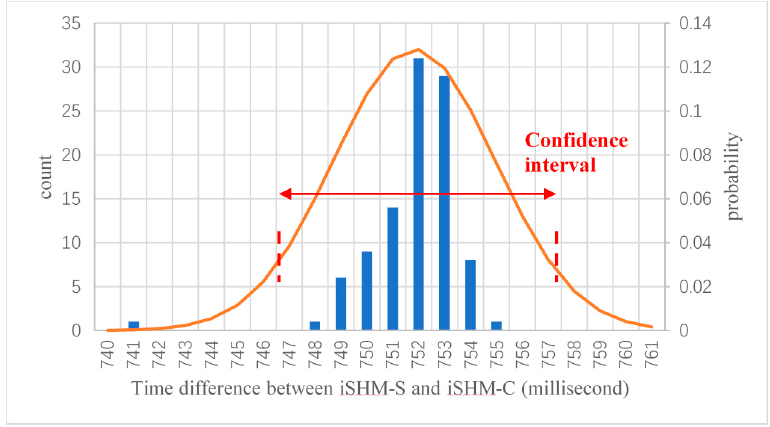
Figure 8. Distribution of estimated time differences Δ𝑡 (cid:2872) of 100-time synchronization tests.